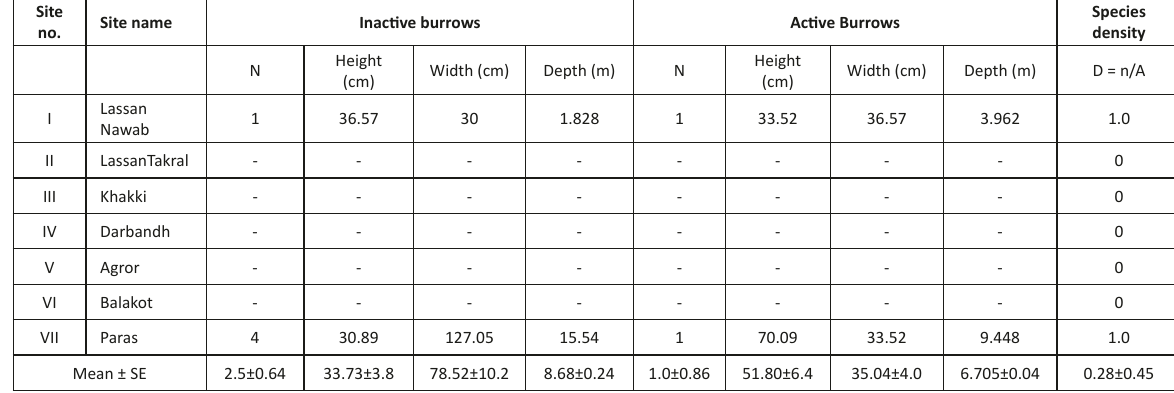
Table 4. Details of living burrows and population density of Indian Pangolin Manis crassicaudata in Mansehra District of KP province during the current study period. Site